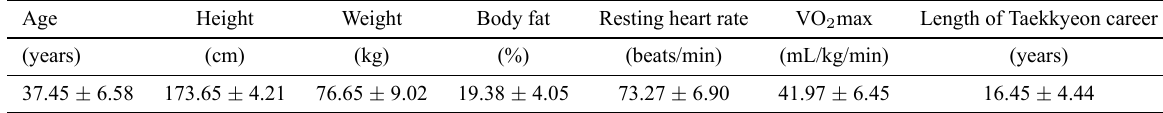
Table 1. General characteristics of the participants ( n =